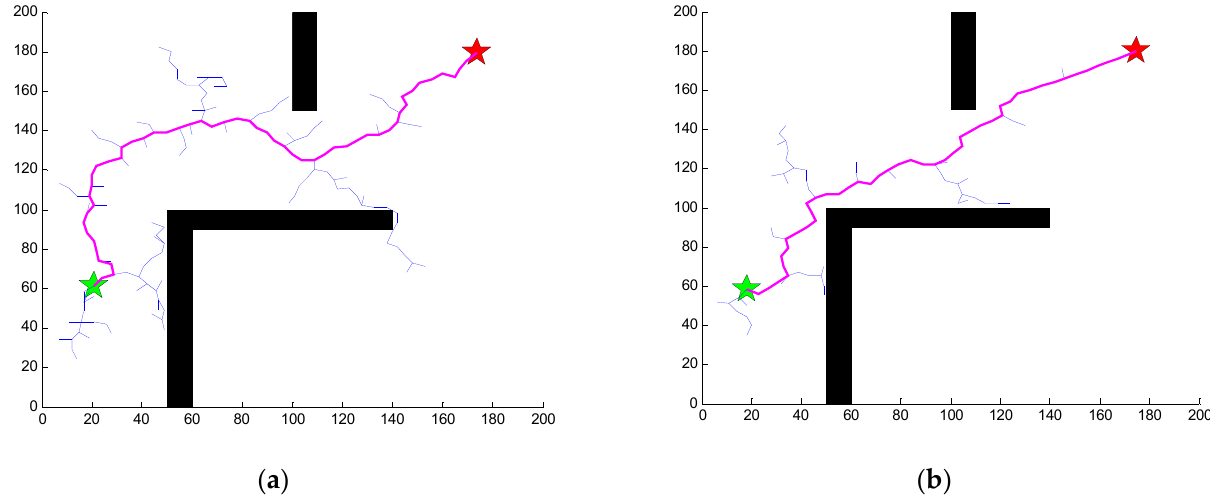
Figure 2. Target bias comparison diagram. ( a ) The basic RRT; ( b ) the improved RRT.